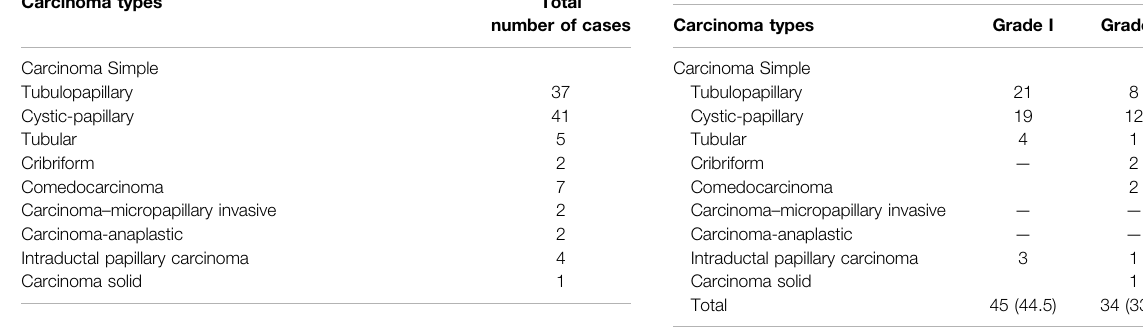
TABLE 1 | Frequency of type of 101 canine mammary tumors in Puglia. TABLE 2 | Frequency of malignant grade of type of 101 canine mammary tumors in